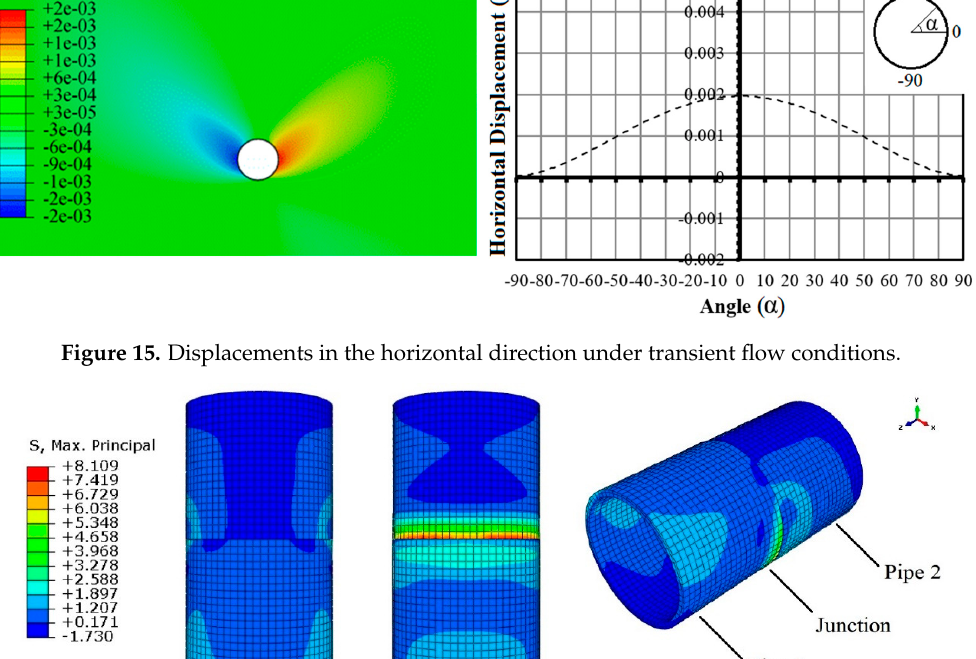
Figure 14. Displacements in the vertical direction under transient flow conditions.